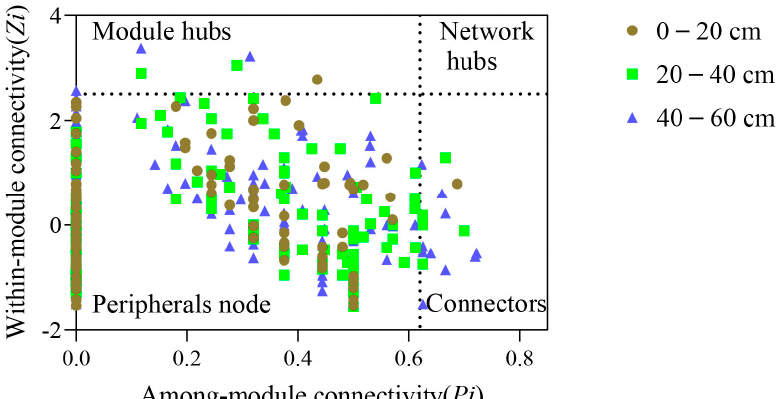
Figure 3. Topological role distribution of bacterial molecular ecological network nodes in three soil layers.